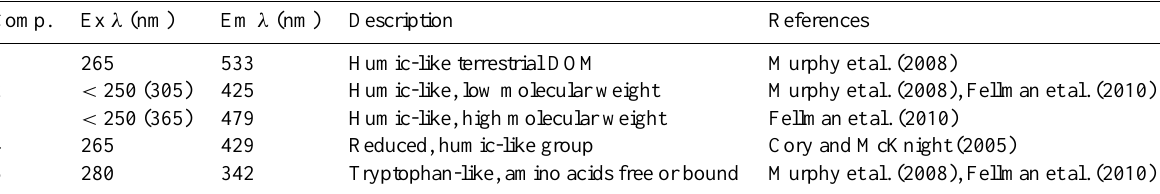
Table 2. Characteristics of identified PARAFAC components. Maximal excitation and emission wavelengths are given, secondary excitation maxima are shown in parentheses. Description contains previously assigned characteristics and names of similar components as shown in the References column.